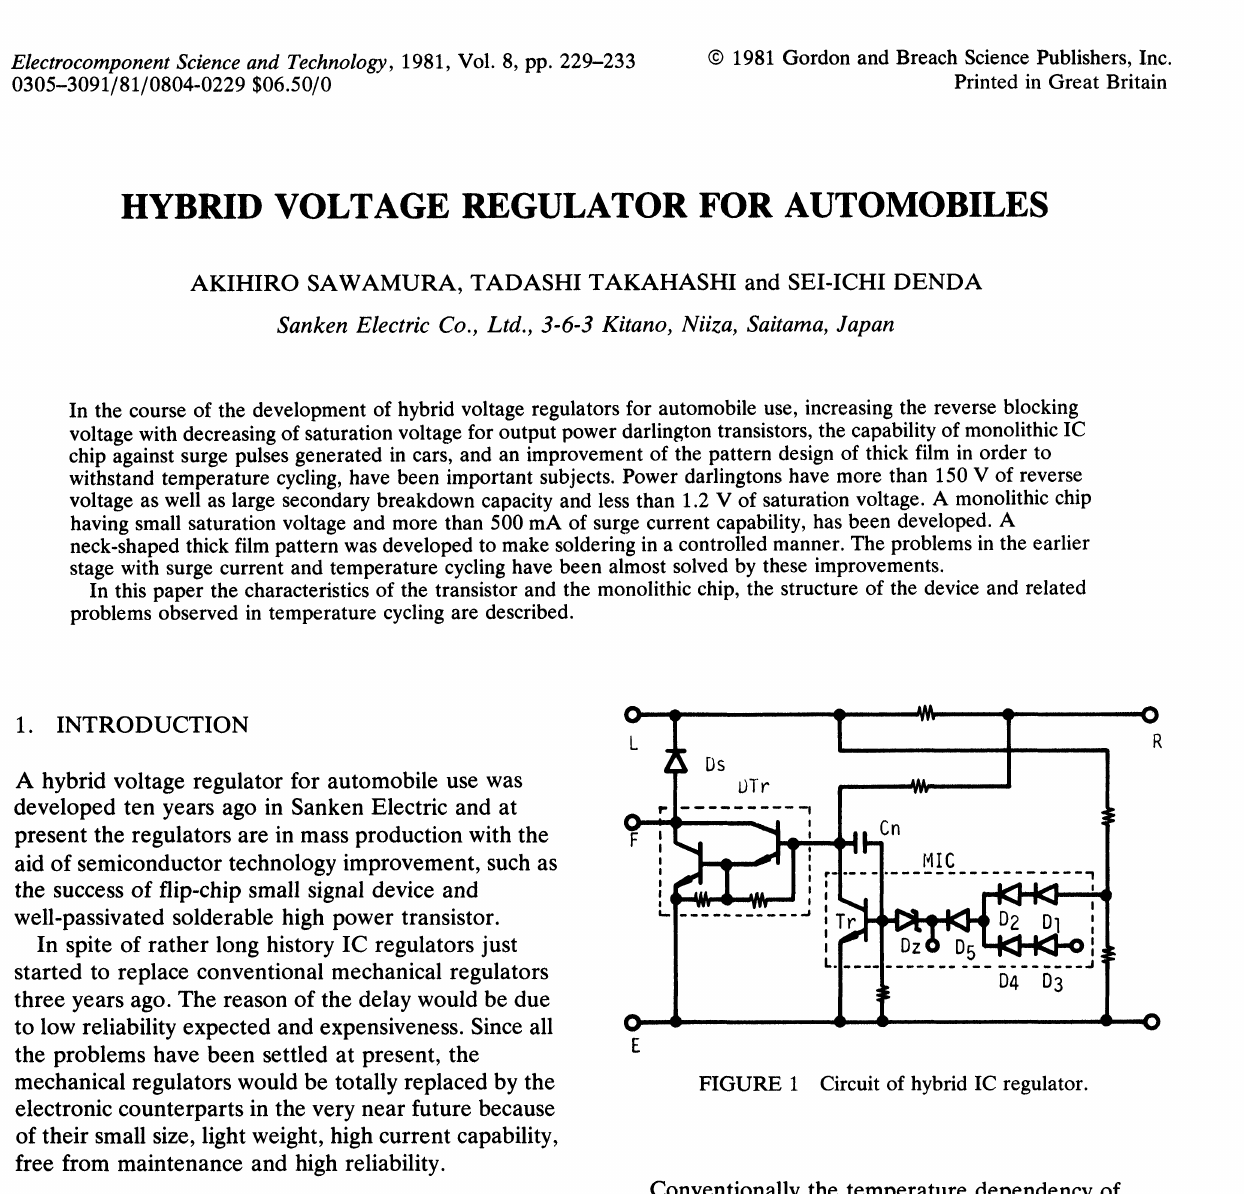
discrete thermistor, silicon diodes, and a zener